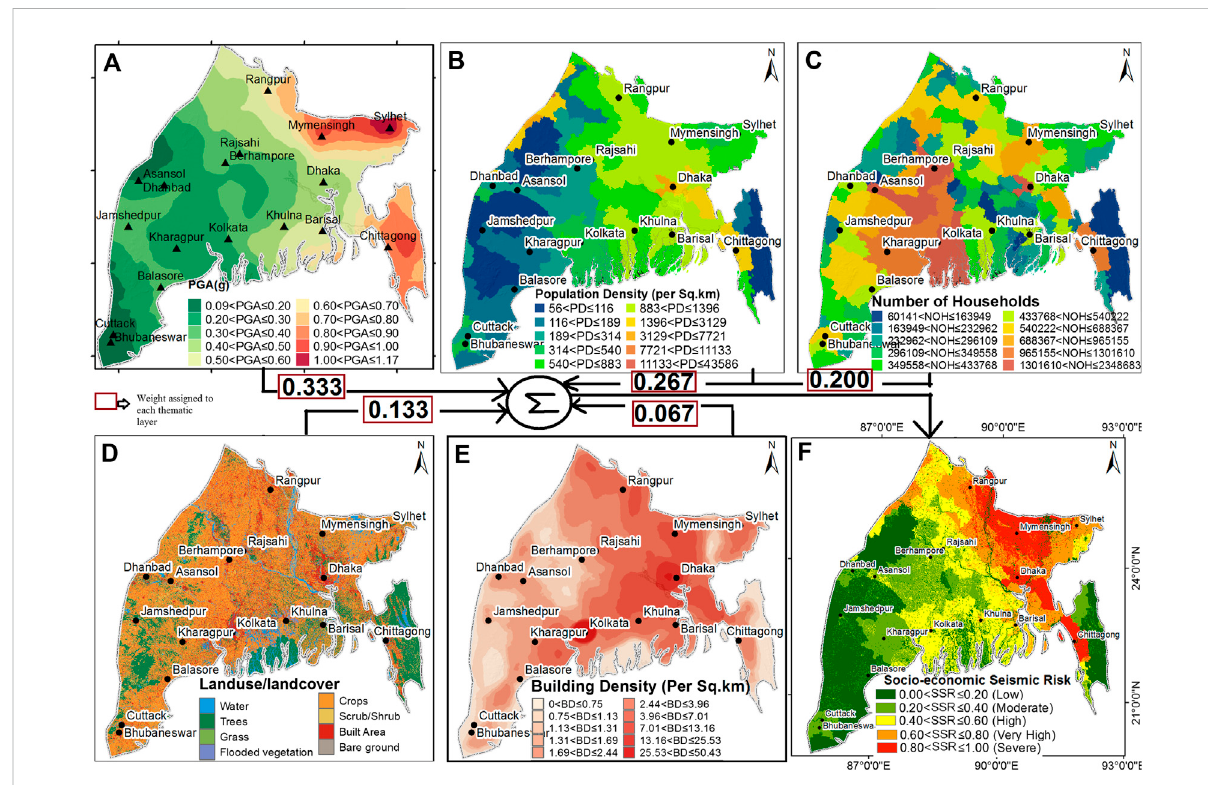
FIGURE 12 Socioeconomicseismicrisk(SSR)zonationmappreparationofBengalBasinbyoverlaying (A) thespatial distributionofsurface-consistentpeak ground acceleration with 10% probability of exceedance in 50 years as a thematic layer and integrating it with the vulnerability components viz. (B) District wise population density per km 2 (adopted from Census of India, 2011 and Census of Bangladesh, 2011), (C) district wise number of households (adopted from Census of India, 2011 and Census of Bangladesh, 2011), (D) land use/land cover (Karra et al., 2021), and (E) building densityperkm 2 byassigning0.333, 0.267,0.200,0.133,and0.067weights,respectively,throughtheanalytichierarchyprocess(AHP)ofSaaty(1980) to produce the socioeconomic seismic risk map of the basin in (F)